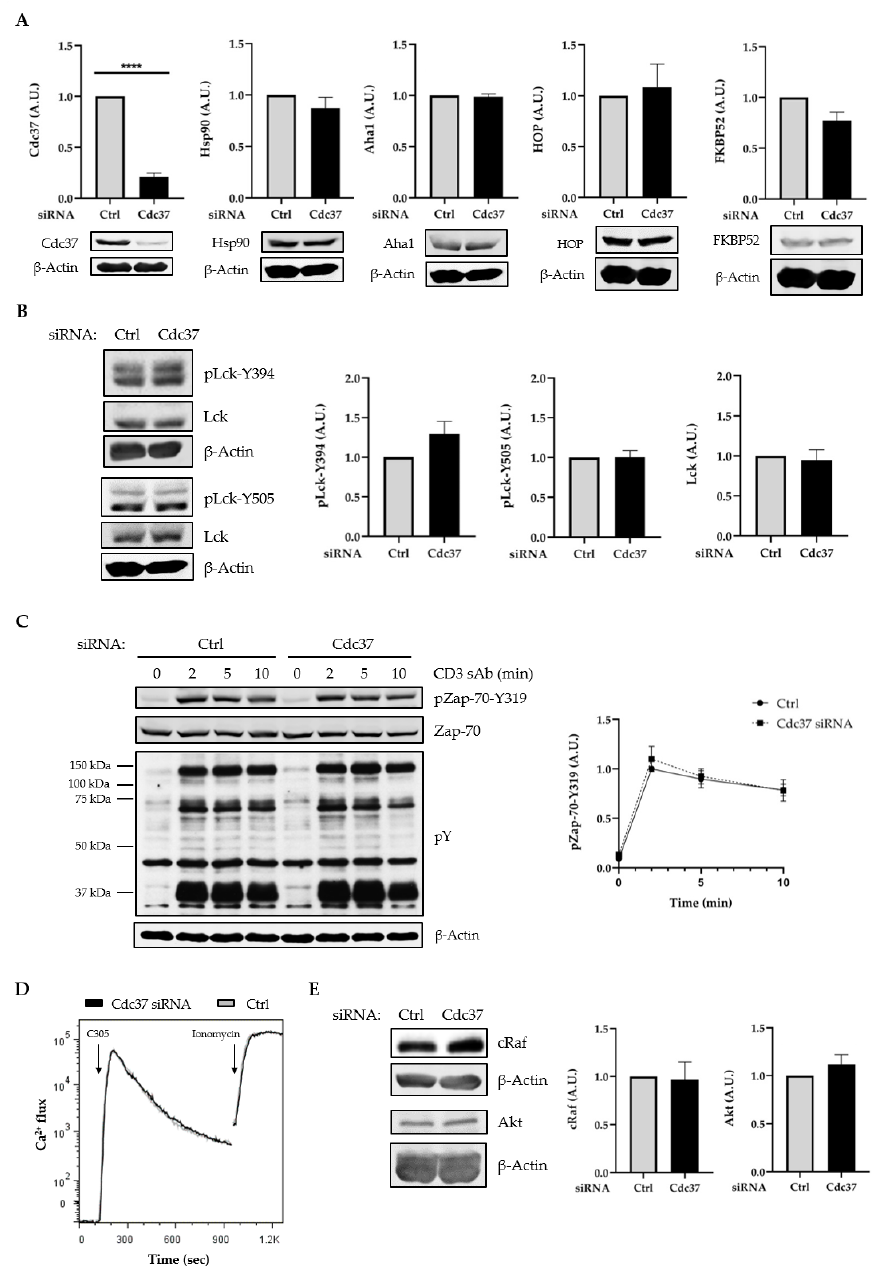
Figure 2. Cdc37 suppression did not impair Lck expression and TCR signaling. JE6 cells were transfected with Ctrl or Cdc37 siRNA and cultured for 48 h. Cell lysates were analyzed by immunoblotting using the indicated Abs. ( A ) Immunoblot showing Cdc37 suppression and the expression of components of the chaperone complex. Bands in ( A ) were quantified using the ImageStudio software and values were normalized to the corresponding β -actin signal. Graphs show the expression levels of the indicated molecules as arbitrary units ± SEM of three independent experiments. ( B ) Immunoblots showing Lck expression and phosphorylation. ( C ) 48 hours after transfection, cells were stimulated with a soluble CD3 antibody (sAb) (clone UCHT1) for the indicated times. Subsequently, lysates were analyzed by immunoblotting. Bands in ( C ) were quantified as in Figure 1. Graph shows the phosphorylation levels of Zap-70 as arbitrary units ± SEM of six independent experiments. ( D ) JE6 cells were incubated with Indo-1AM and stimulated with the TCR clonotypic antibody C305, and Ca 2+ flux was measured by flow cytometry. Ionomycin was used to induce maximum Ca 2+ flux. ( E ) Immunoblots showing Akt and cRaf expression. Graphs show the expression levels of indicated molecules as arbitrary units ± SEM of three independent experiments. Significant p -values were calculated using the Student’s t -test (****, p <